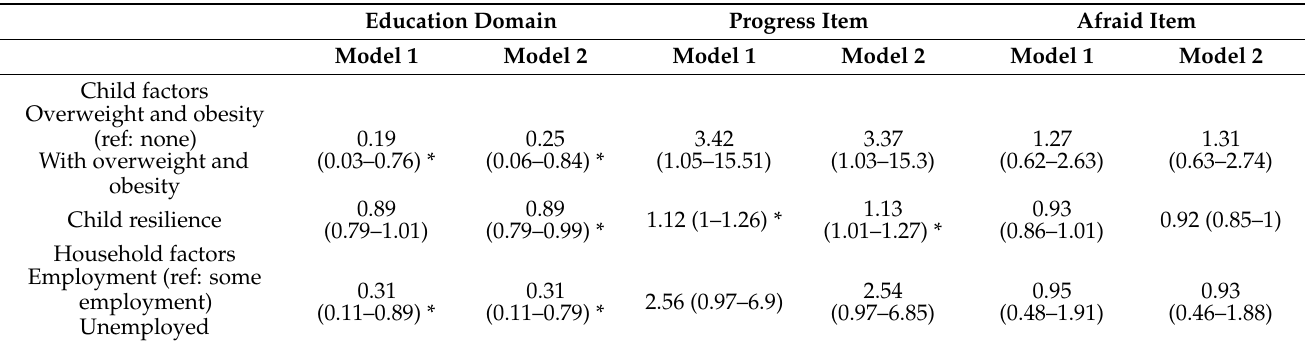
Table 7. Individual- and household-level factors that are associated with the child education domain with adjustment for community level factors using school classification (fee-paying or non-fee- paying). Progress Item Afraid Item Model 1 Model 2 Model 1 Model